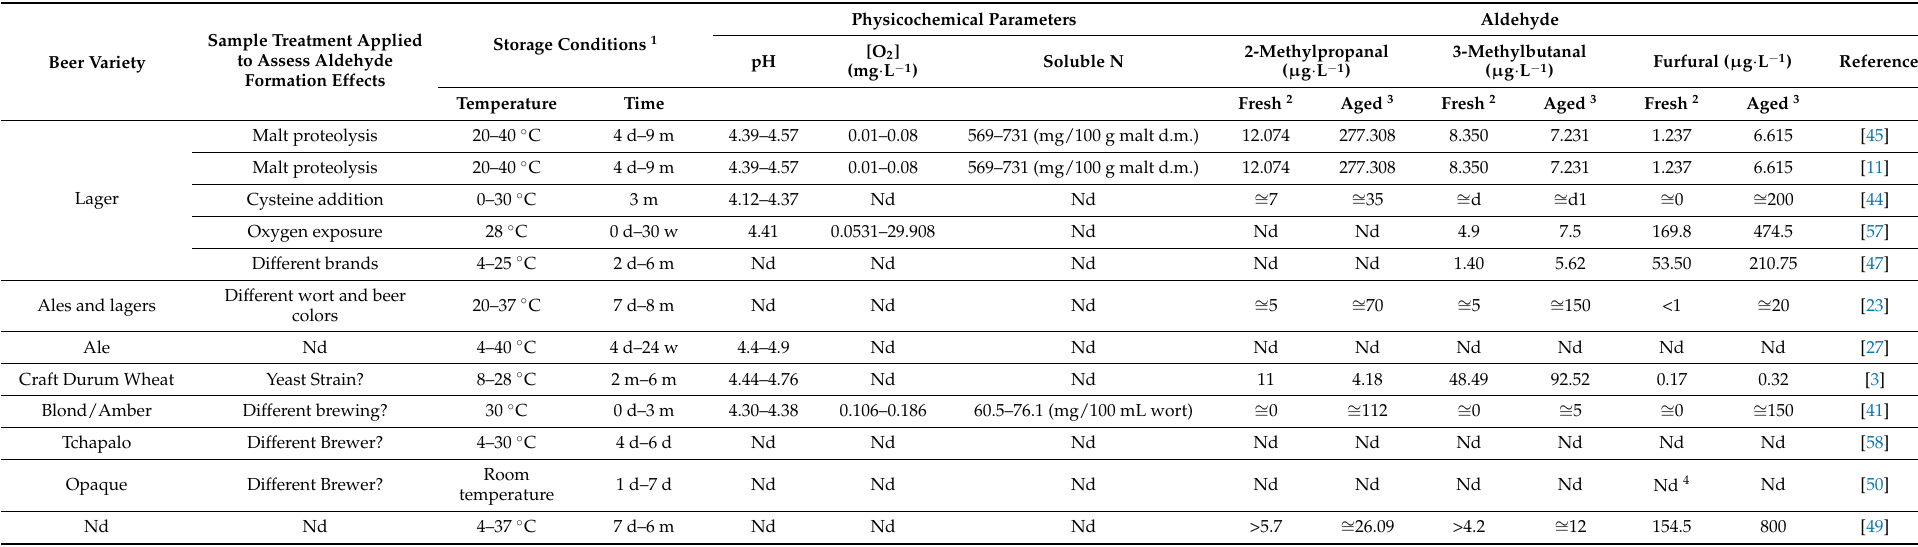
Table 3. Natural or forced beer aging reports and their